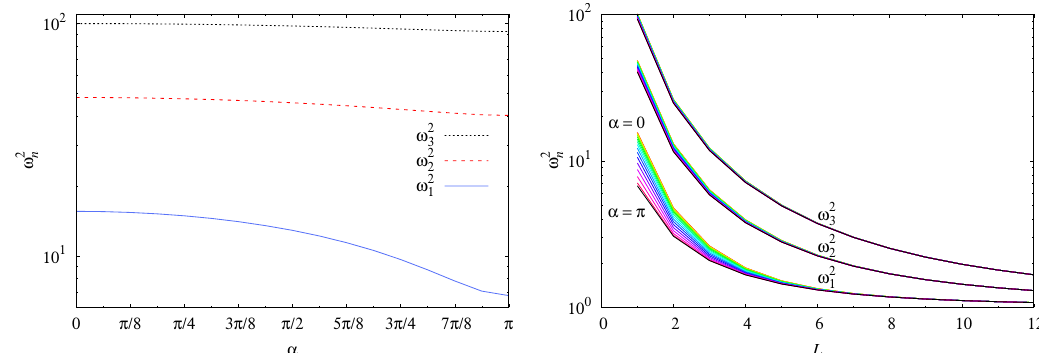
Figure 10. The (cid:12)rst three energy levels ! 2 ( n = 1 ; 2 ; 3) of (2.14), calculated with potential (cid:21) ( x ), n for L = 1 and as functions of (cid:11) (on the left), and, for various (cid:11) , as functions of L (on the right). The colors used in the right panel are shown in the legend of (cid:12)gure